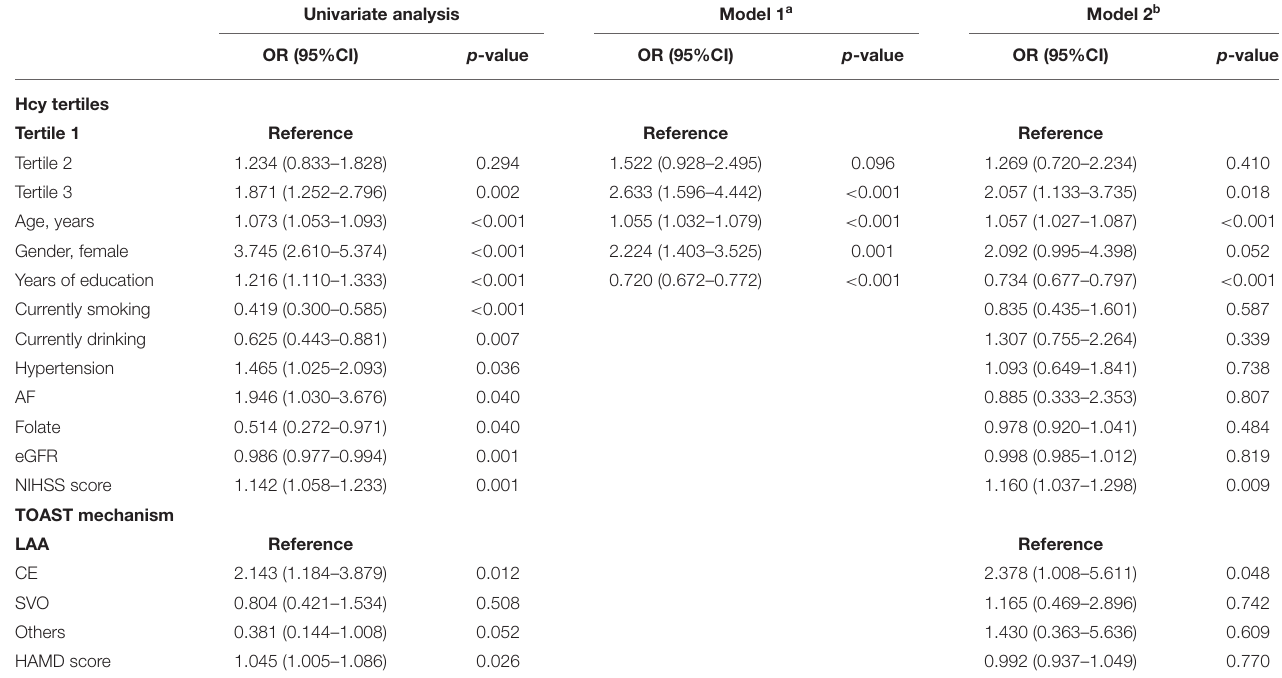
TABLE 3 | Multivariate logistic analysis for the association between Hcy levels and cognitive